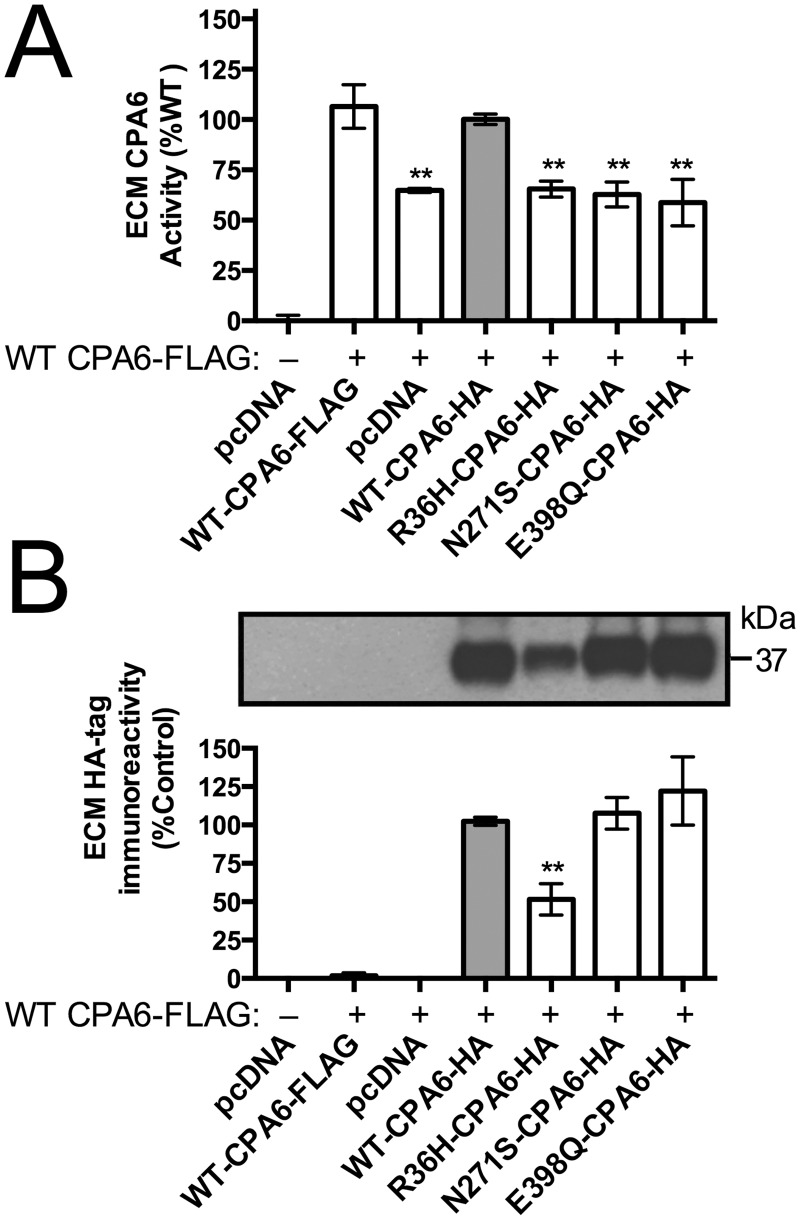
Co-expression of WT and mutant proCPA6 in HEK293T cells.HAH6-tagged or FLAG-tagged wild-type (WT) and HAH6-tagged mutant proCPA6 were co-expressed in HEK293T cells by transient transfection and ECM was analyzed. (A) Enzyme activity of CPA6 in the ECM was assayed using 3-(2-furyl)-acryloyl-Phe-Phe. In co-expression experiments, approximately 55–65% activity was seen when WT-CPA6-FLAG was coexpressed with either of the two inactive mutants (Asn271Ser and Glu398Gln), with the Arg36His mutant, or with empty pcDNA vector; the difference in means between these 4 groups was not statistically significant. (B) HA-tag immunoreactivity in the ECM, measured by western blotting, showed a 50% reduction for Arg36His-CPA6 while levels were unchanged for Asn271Ser and Glu398Gln mutants. Error bars show standard error of the mean in panels A (n≥7) and B (n≥4). **, p<0.01.